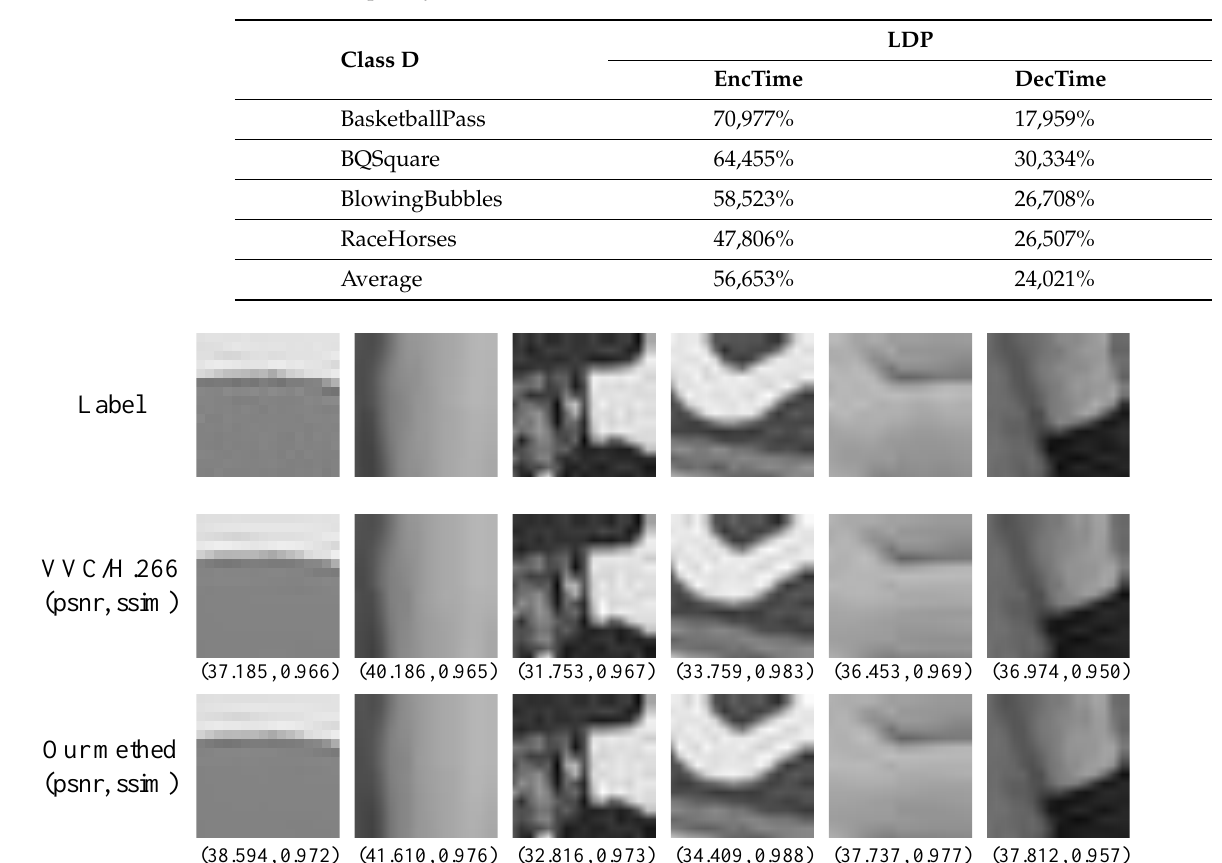
Figure 9. Quality enhancement results on reference CU performed by the